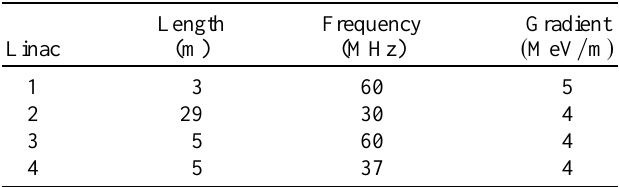
TABLE IV. Parameters of the lower energy phase rotation linacs.